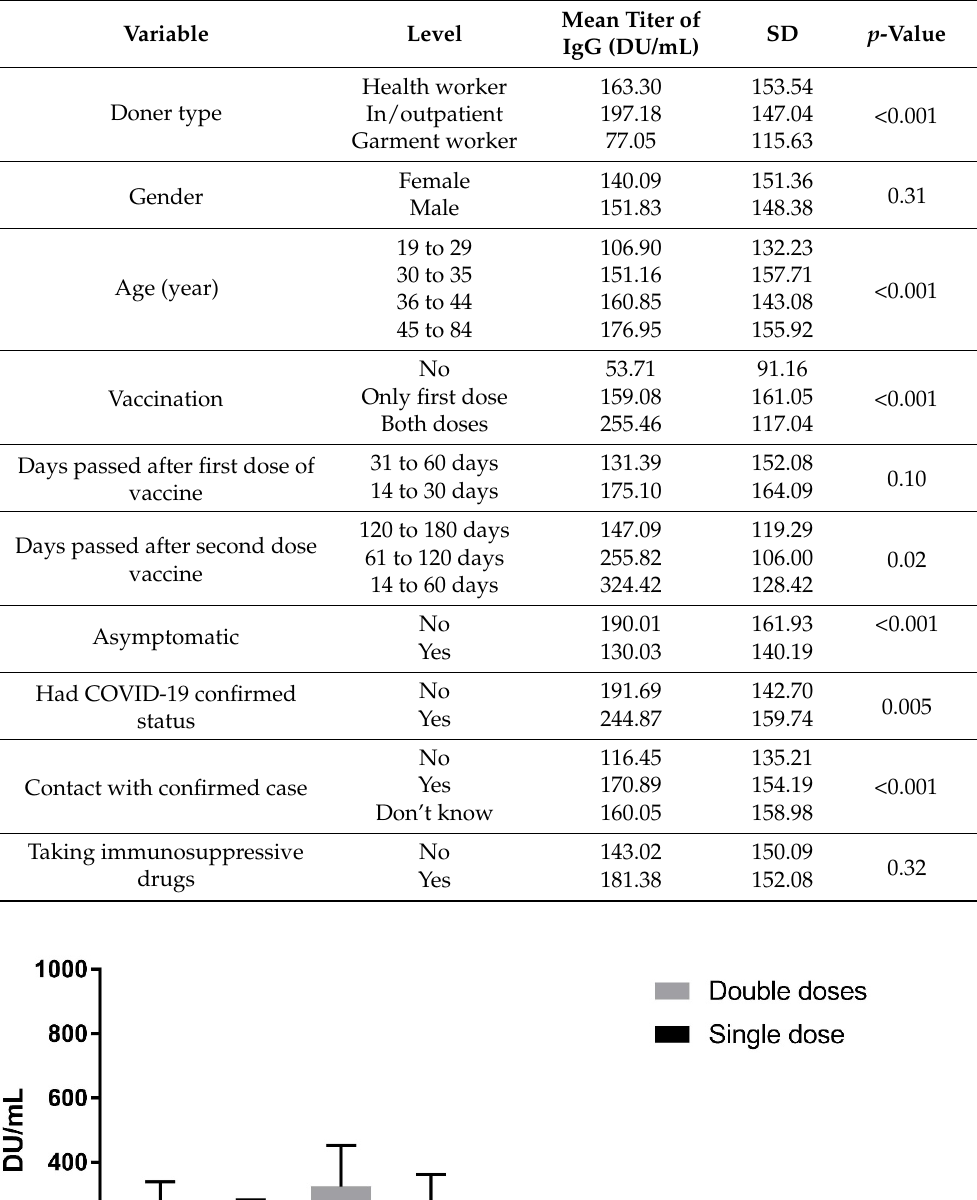
Table 3. Univariable analysis ( t -test, one way ANOVA) to evaluate the mean difference in the quantity of anti-SARS-CoV-2 antibody in the serum samples.